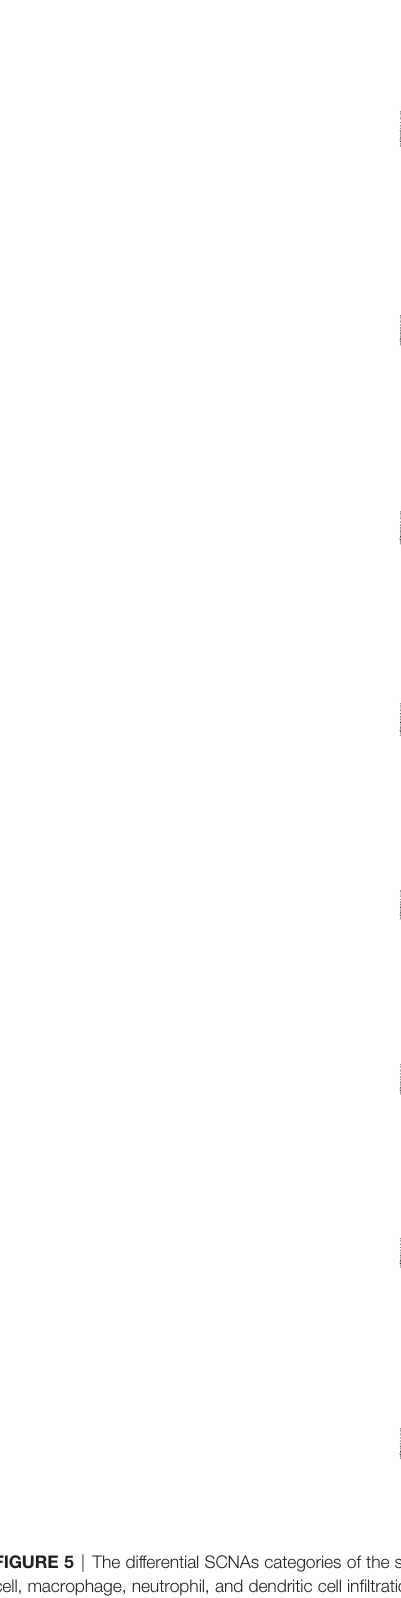
Frontiers in Oncology |